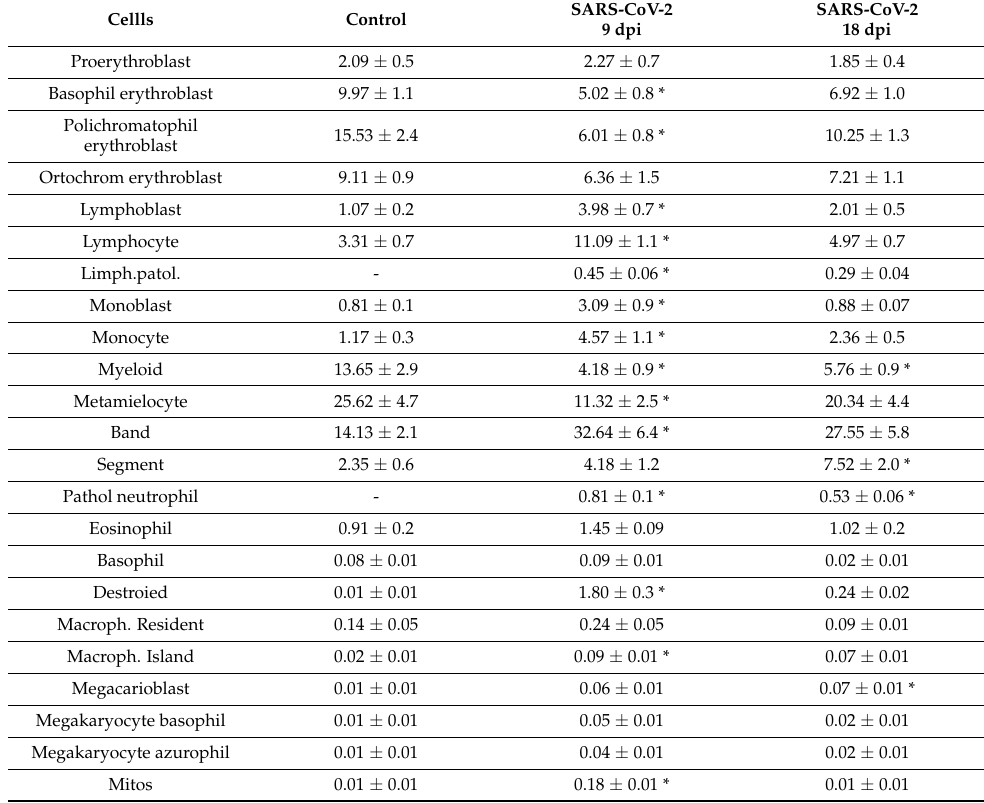
Table 3. Bone marrow cell populations in norm and under the action of SARS-CoV-2.